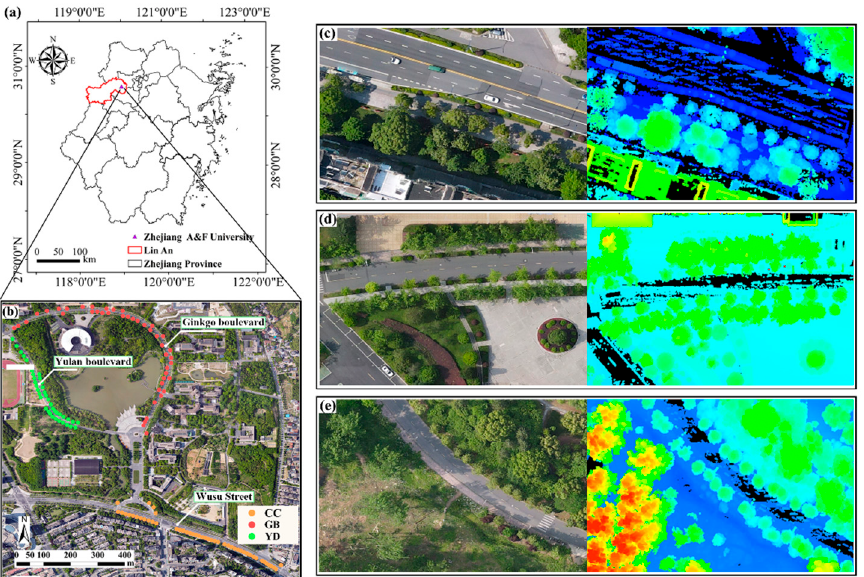
Figure 1. Map of the study area. ( a ) Location in Zhejiang Province, ( b ) distribution of all samples of the three tree species in the study area, ( c – e ) on the left are parts of the visible light images of CC, GB, and YD, and on the right are the corresponding laser radar point cloud images.